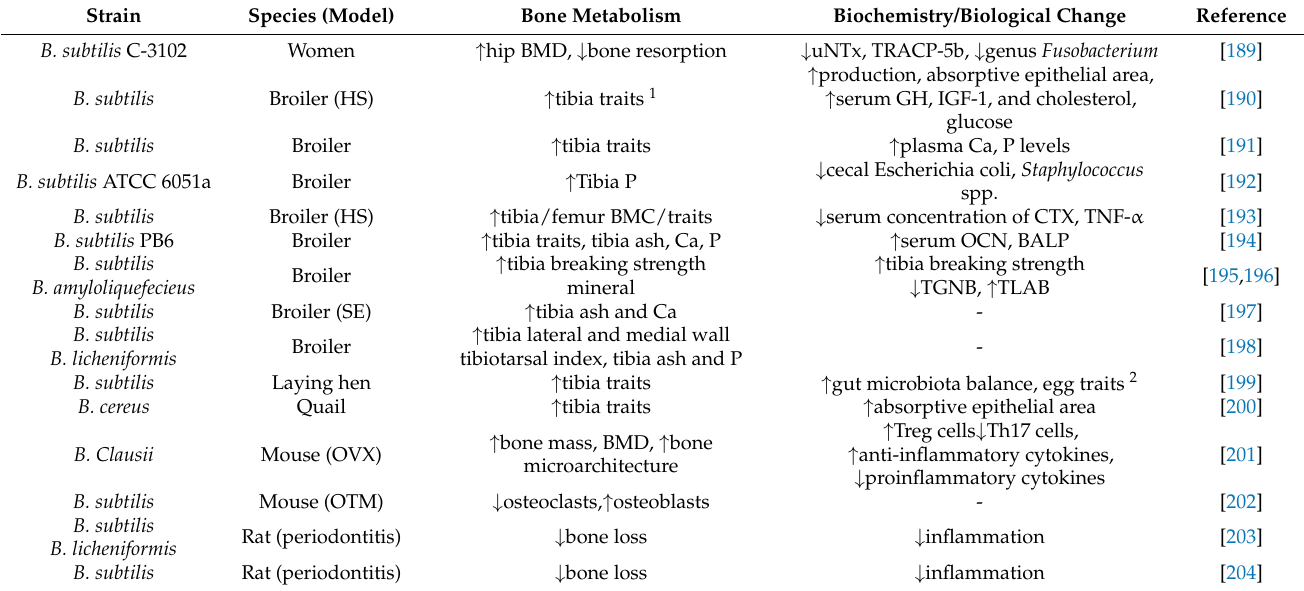
Table 2. Effects of Bacillus probiotics on bone